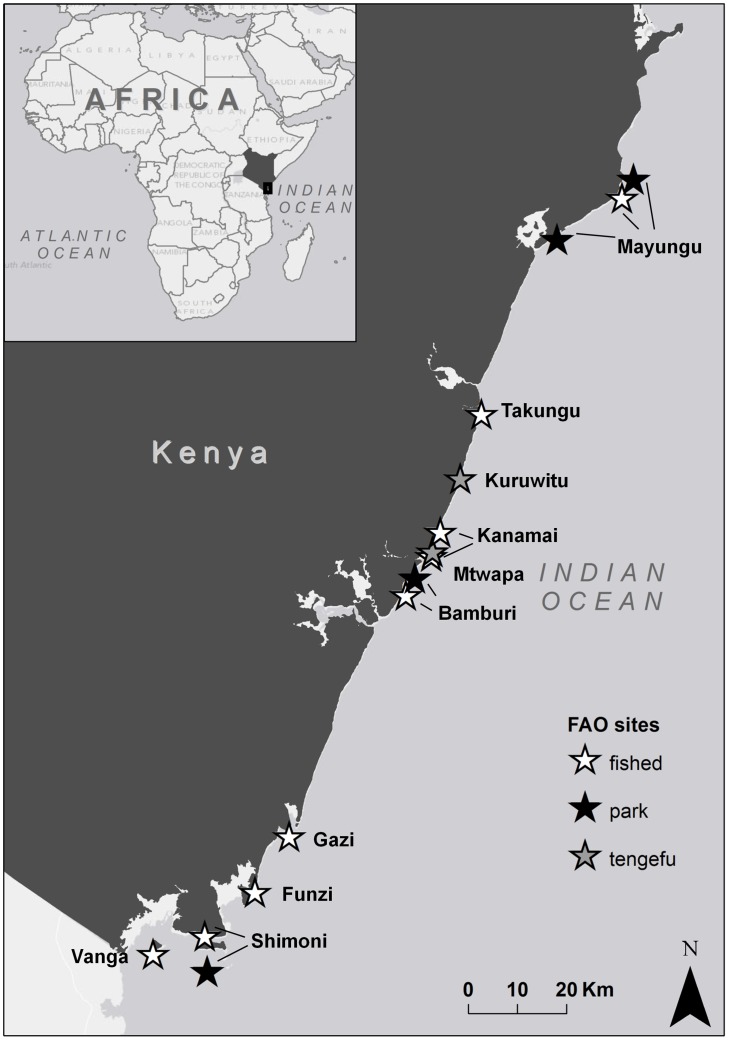
Map of study sites.